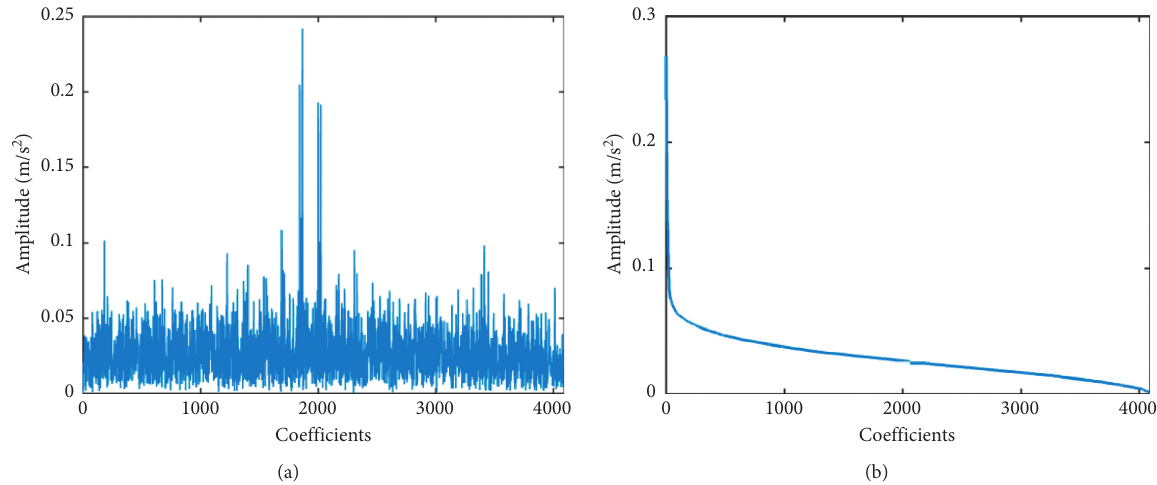
Figure 8: In Fourier dictionary, (a) sparse coefficients of the noisy signal; (b) attenuation curve of